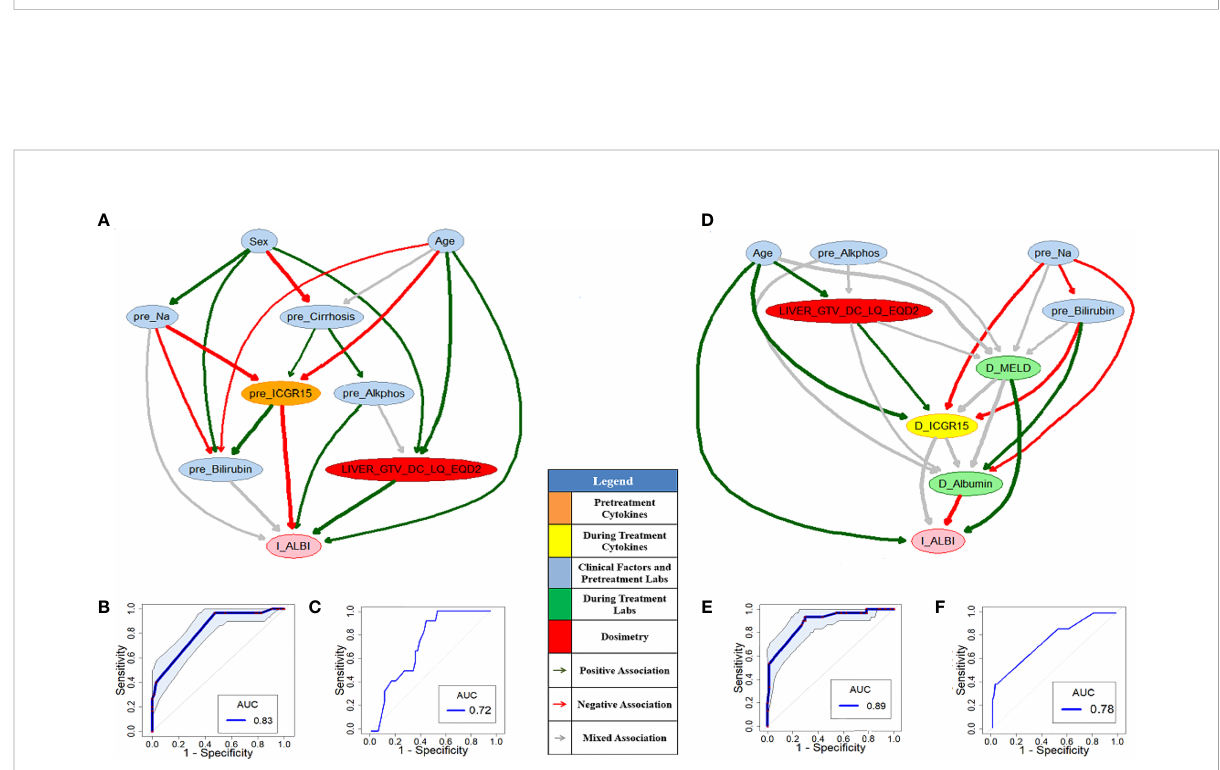
FIGURE 5 Pre- (A) and during-treatment (D) HITL-BNs for I-ALBI prediction. The prediction performance of pre- (B) and during-treatment (E) HITL-BNs based on the discovery dataset. The prediction performance of pre- (C) and during-treatment (F) HITL-BNs based on the testing dataset.